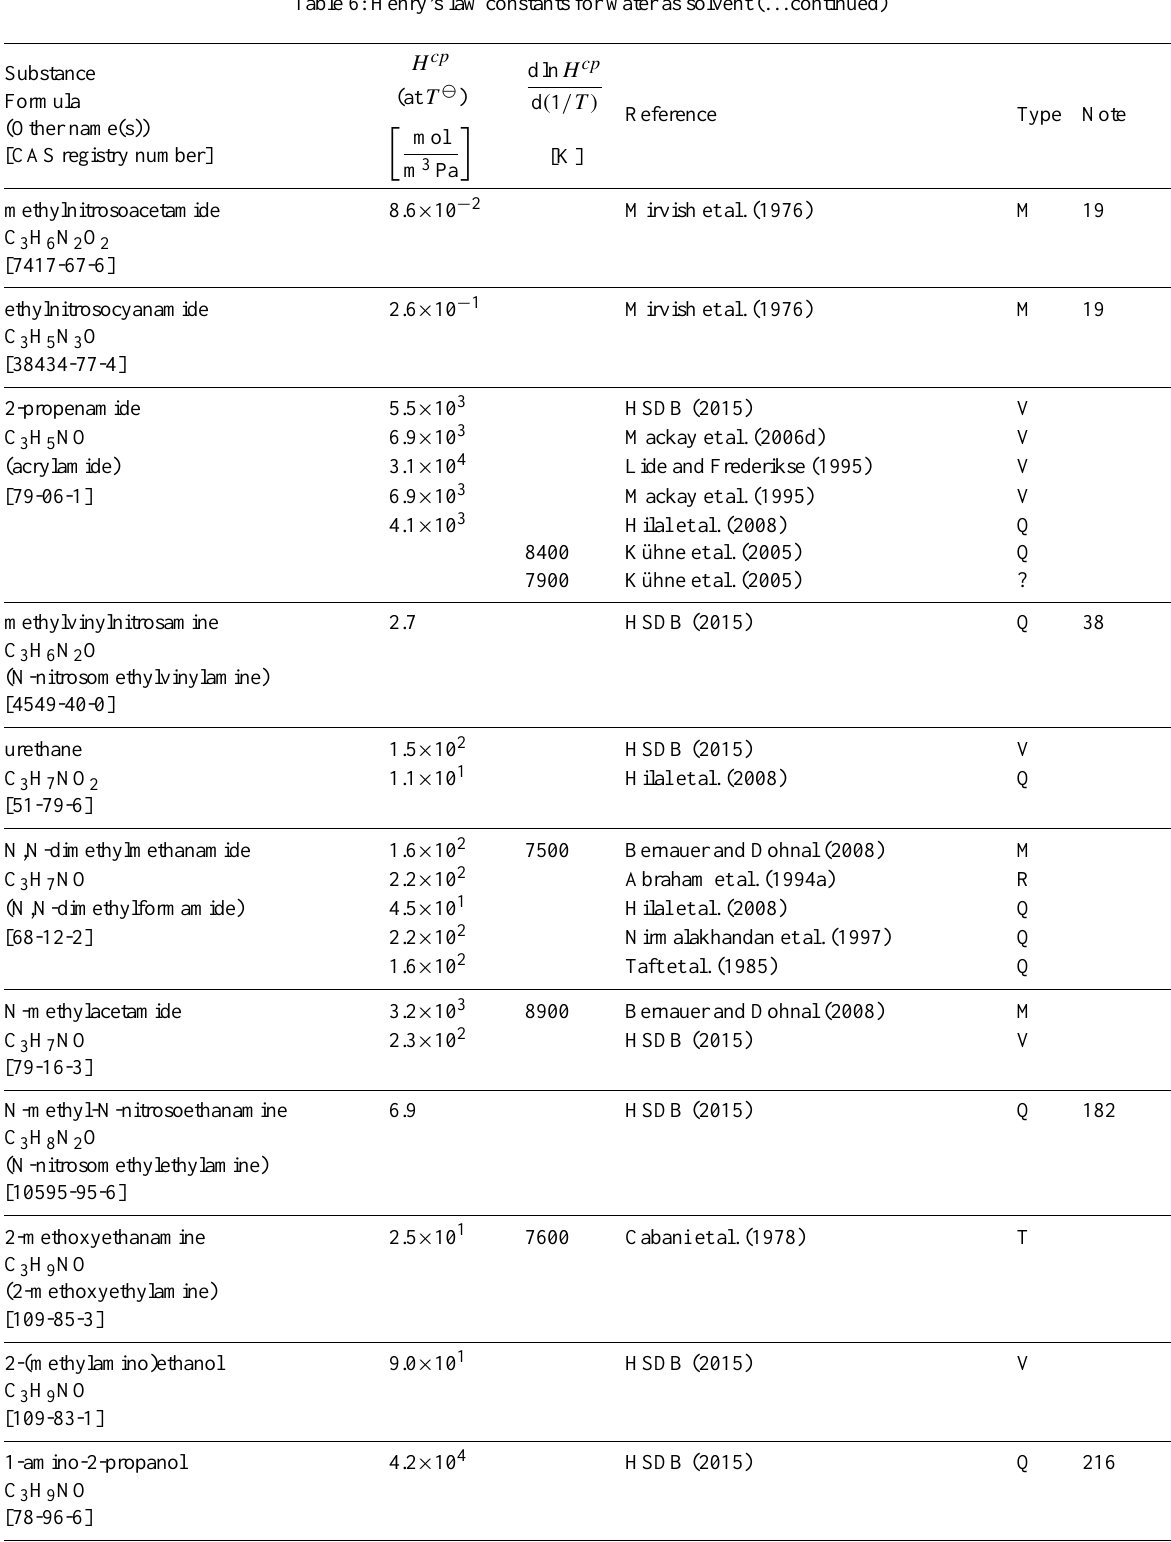
Table 6: Henry’s law constants for water as solvent